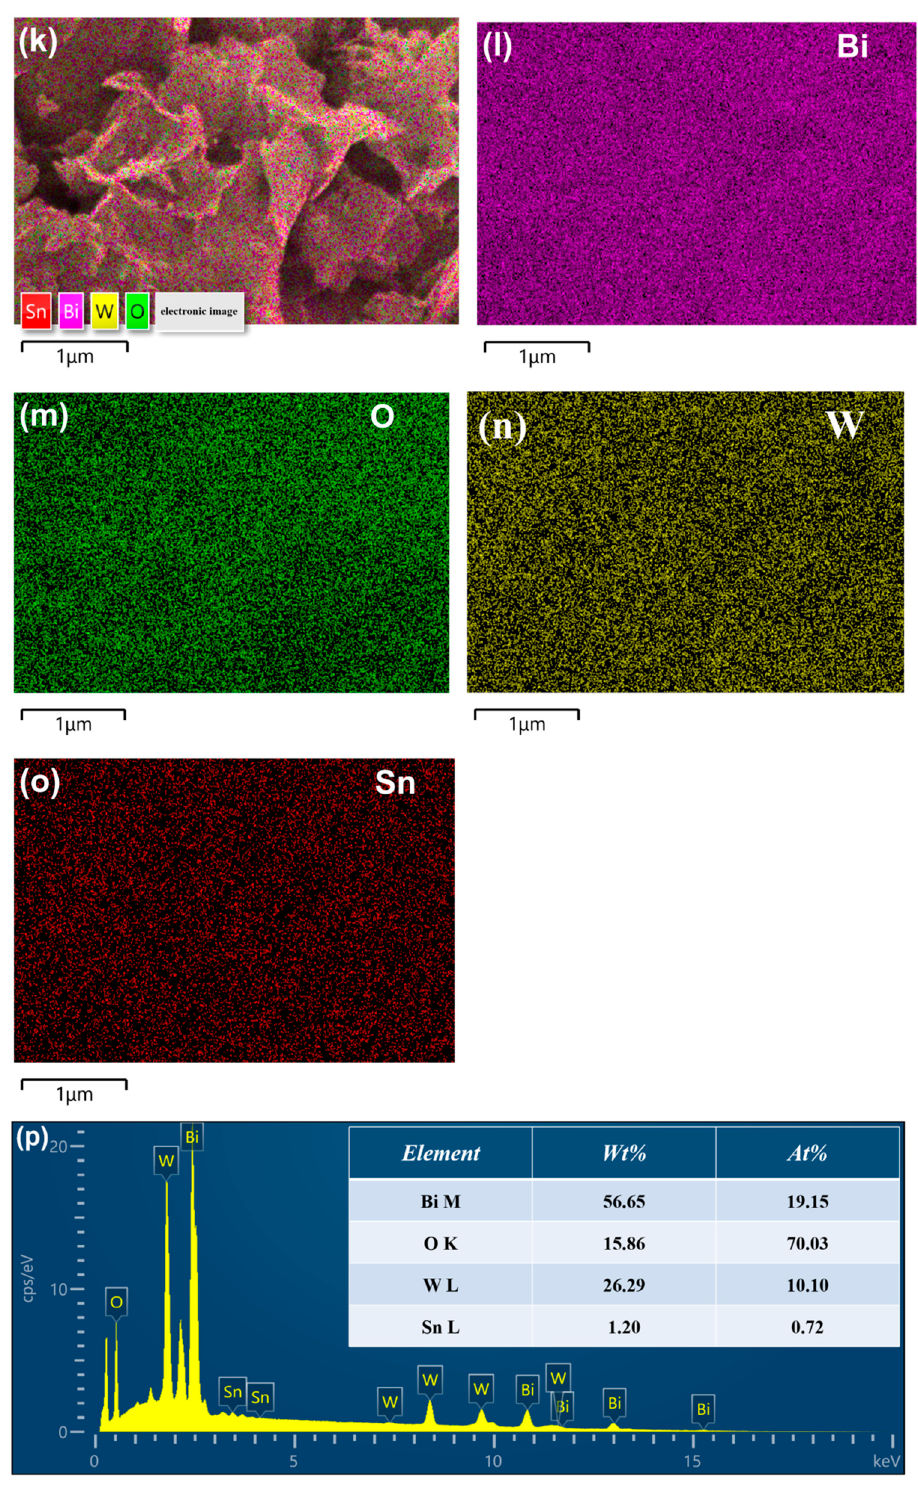
Figure 2. SEM images of pure Bi 2 WO 6 ( a , b ), 1%Sn-Bi 2 WO 6 ( c , d ), 2%Sn-Bi 2 WO 6 ( e , f ), 4%Sn-Bi 2 WO 6 ( g , h ), and 6%Sn-Bi 2 WO 6 ( i , j ), element mappings of Bi, O, W, Sn ( k – o ), and EDS analysis of 2%Sn- Bi 2 WO 6 ( p ).